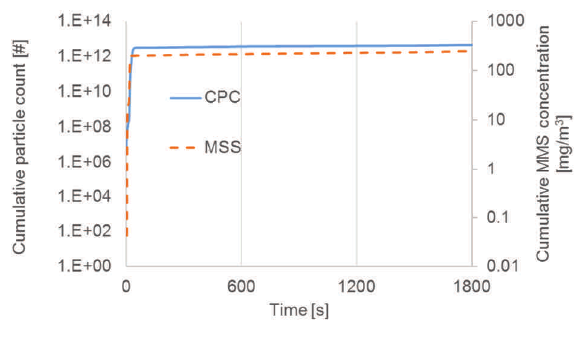
Fig. 10. Cumulative CPC (solid particles only) and MSS readings from vehicle 3 over the WLTP (note the log 10 scales on both vertical axes)